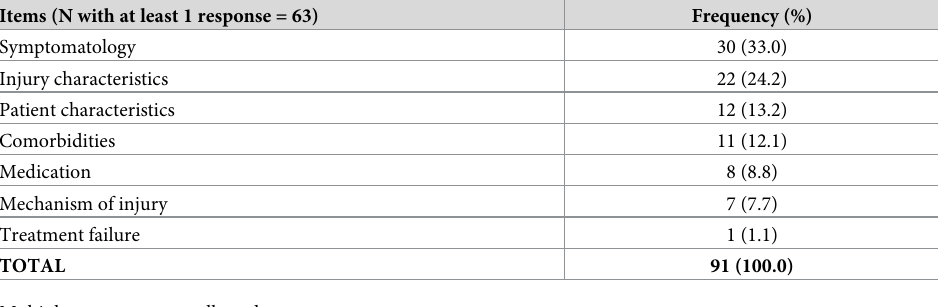
Table 3. Factors contributing to differences in care from one patient to the